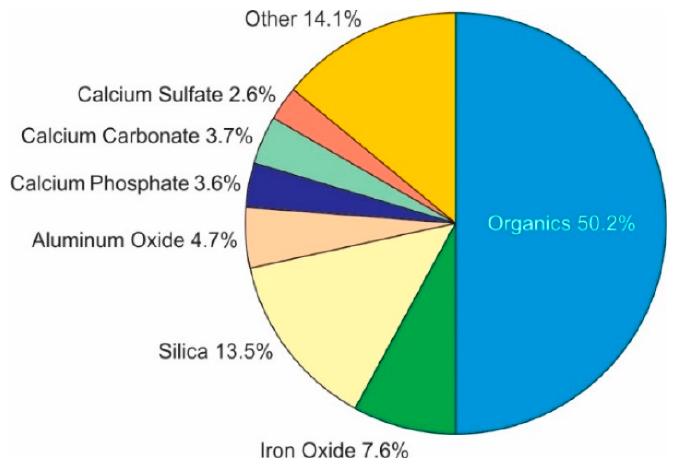
Figure 1. Average foulant distribution, excluding biofouling, from one hundred fifty worldwide membrane autopsies. All membranes showed at least some biofouling and for 33% of the membranes, the degree of biofouling was enough to be the primary mode of performance failure [13]. Used with permission of the Engineers’ Society of Western Pennsylvania.